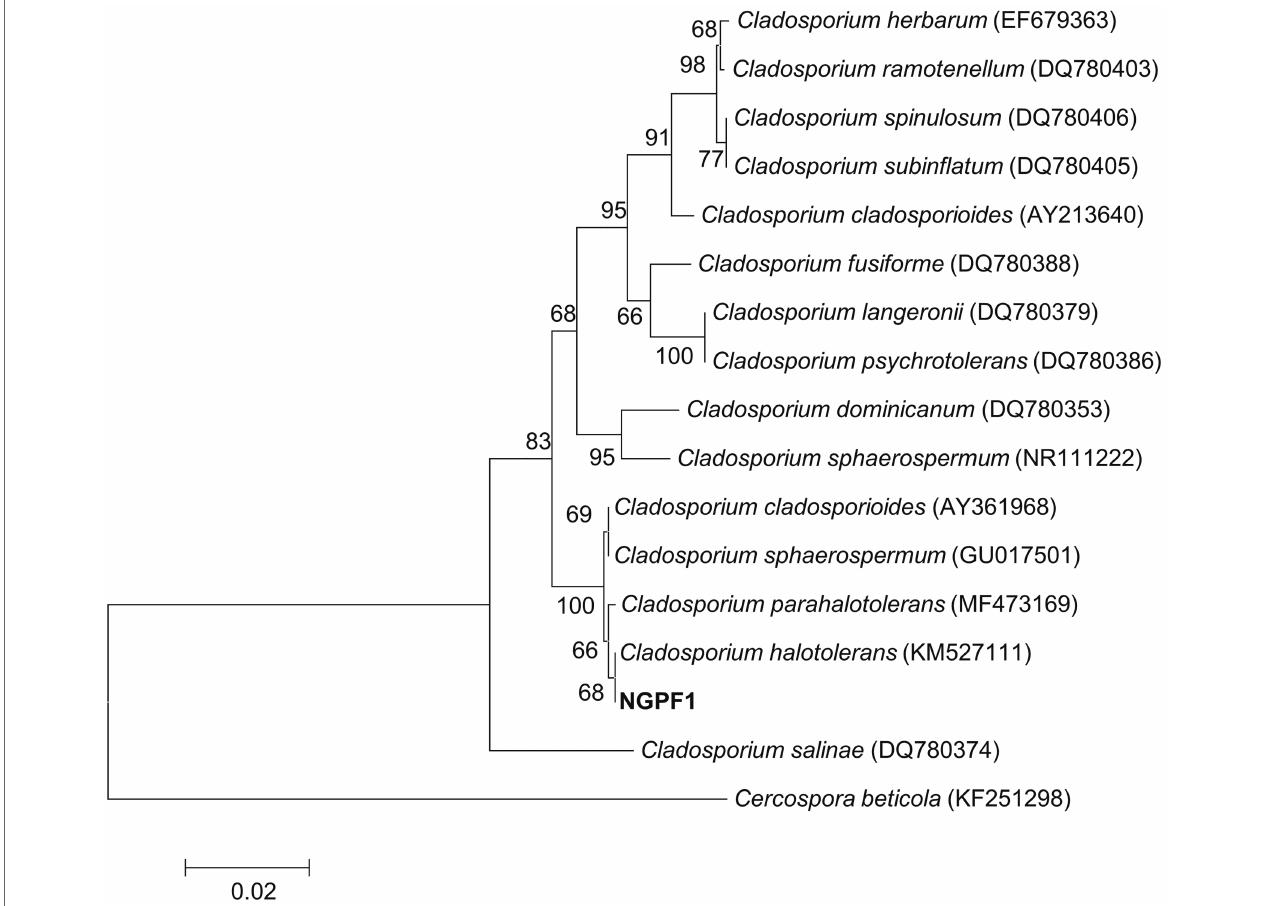
FIGURE 1 | Neighbor-joining (NJ) phylogenetic tree based on ITS gene of strain NGPF1 and closely related members of the genus Cladosporium . Bootstrap values (>50%) calculated using the NJ algorithms are shown. Scale bar: 0.020 substitutions per nucleotide